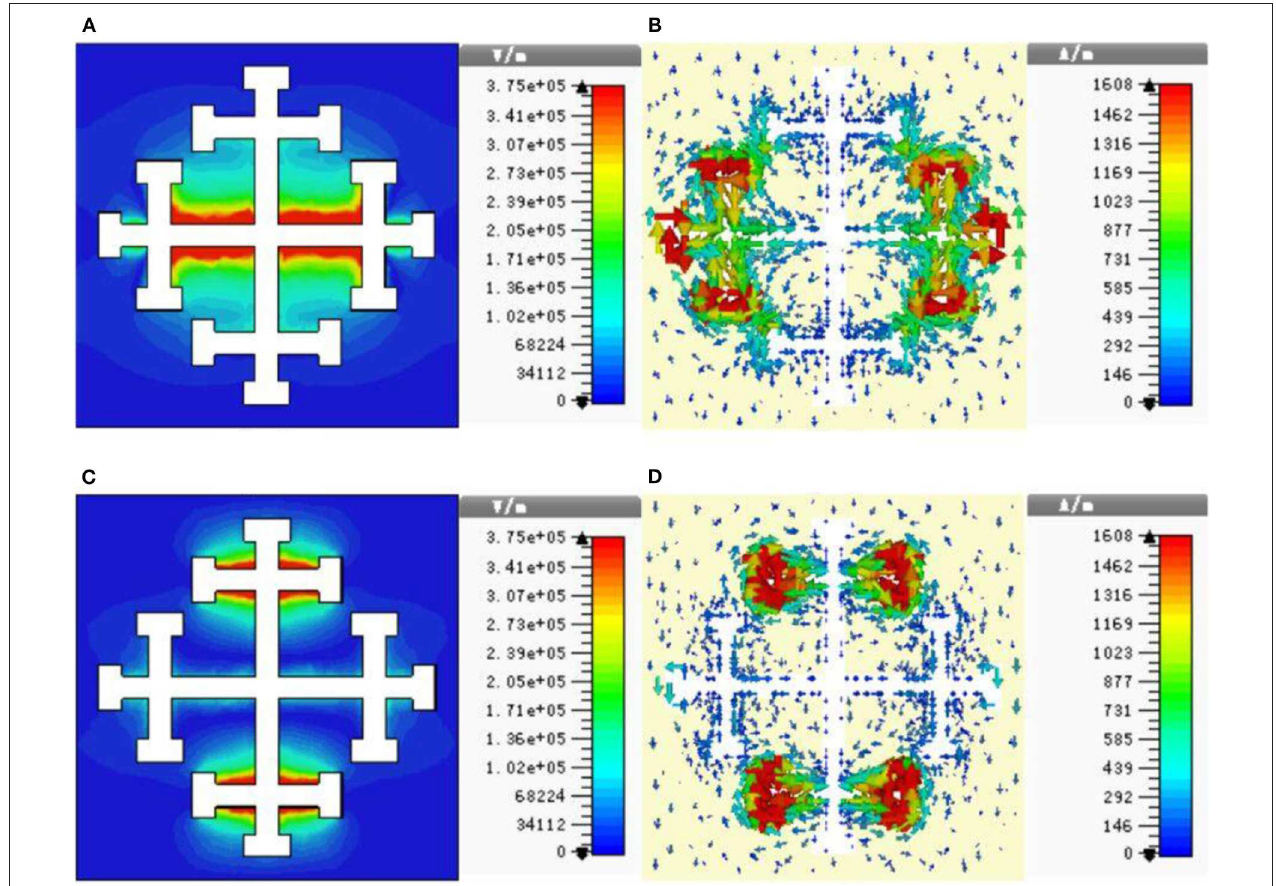
FIGURE 4 | Electric field distribution of the unit cell at the resonance frequency of (A) 0.24 THz and (C) 0.64 THz and the simulated surface current distribution on the crossing fractal layer at the resonance frequency of (B) 0.24 THz and (D) 0.64 THz.